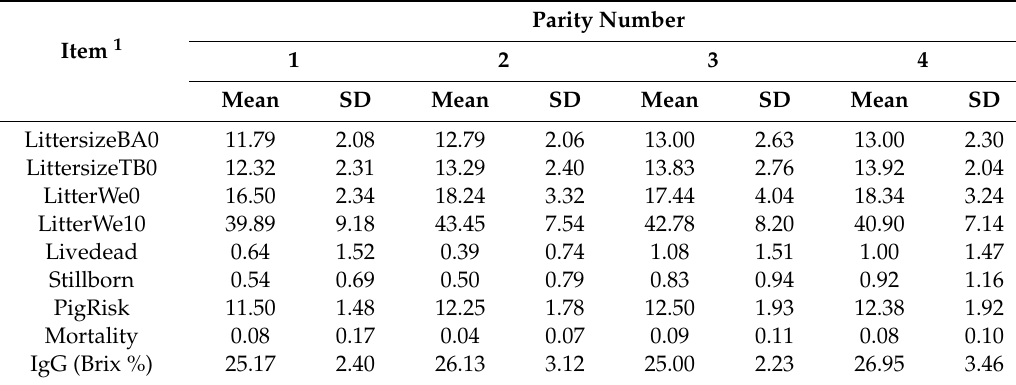
Table 1. Descriptive statistics of sow production traits by parity